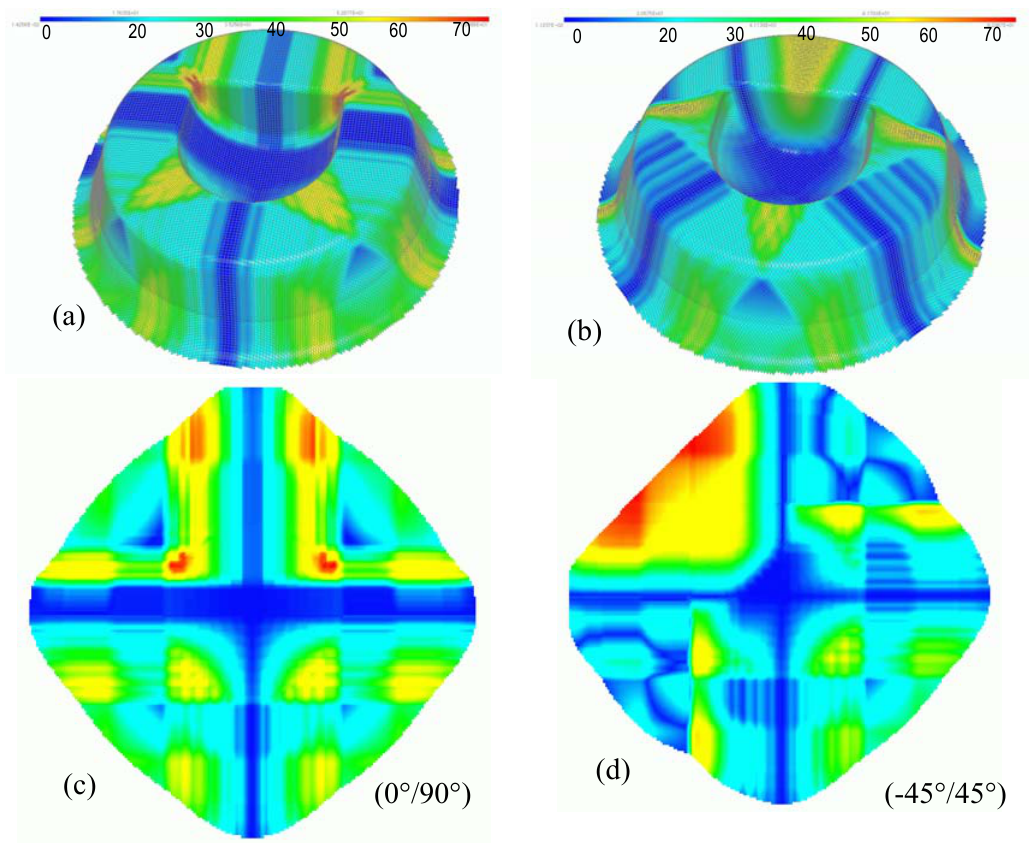
Figure 17. Draping of the CAD surface and corresponding 2D flat pattern.